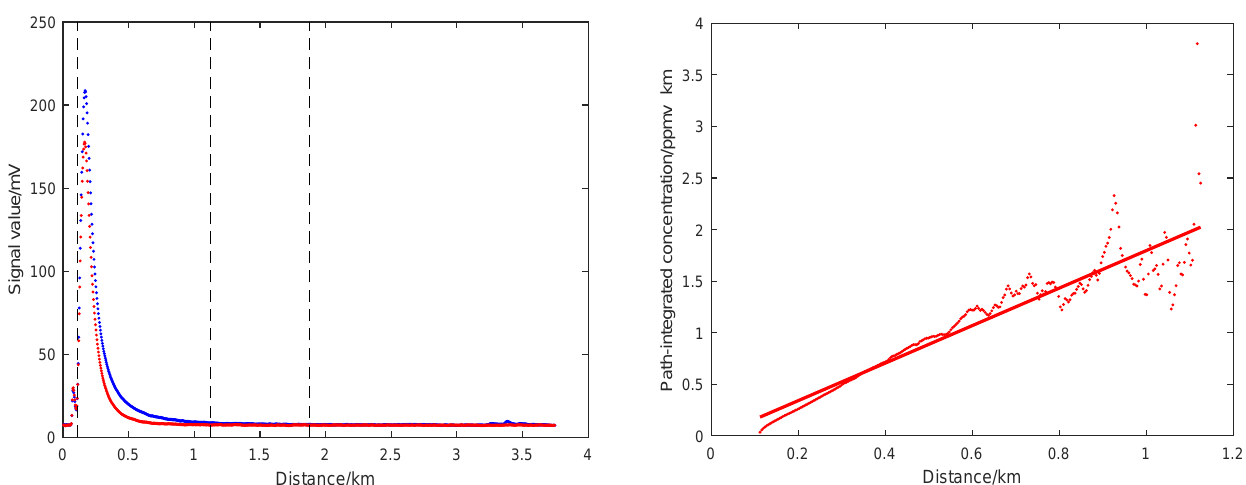
Figure 1. Measured signals (at off-resonant wavelength in blue and on-resonant wavelength in red), and the positions defined by indices m low , m hgh , and m far (vertical dashed lines, left to right) of the endpoints of the windows of data used in each step of the two-step LLS approach.